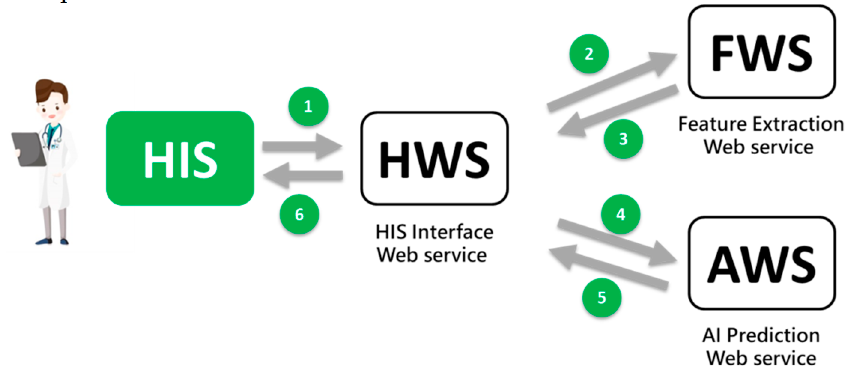
Figure 2. AI Web Service Interaction.